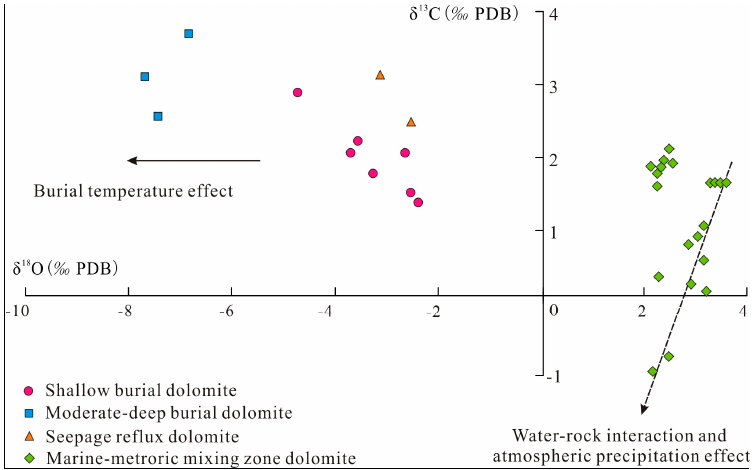
Figure 8. Relation between oxygen and carbon isotopic values in dolomite. The green diamonds data is from Frank and Lohmann (1996) [66] .